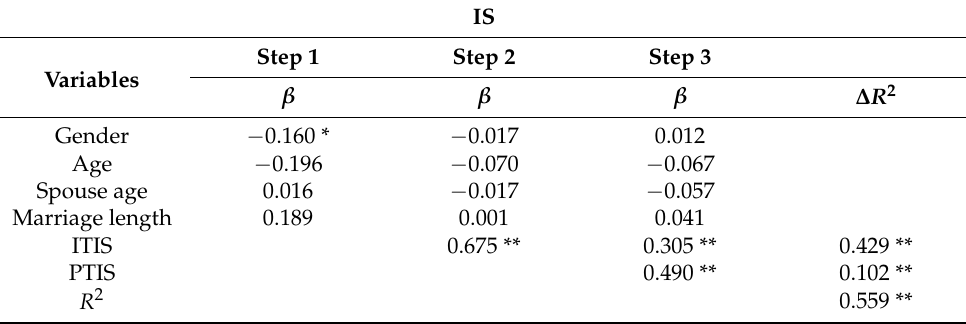
Table 5. Hierarchical regression model for unfaithful behavior (IS). IS Step 1 Step Variables